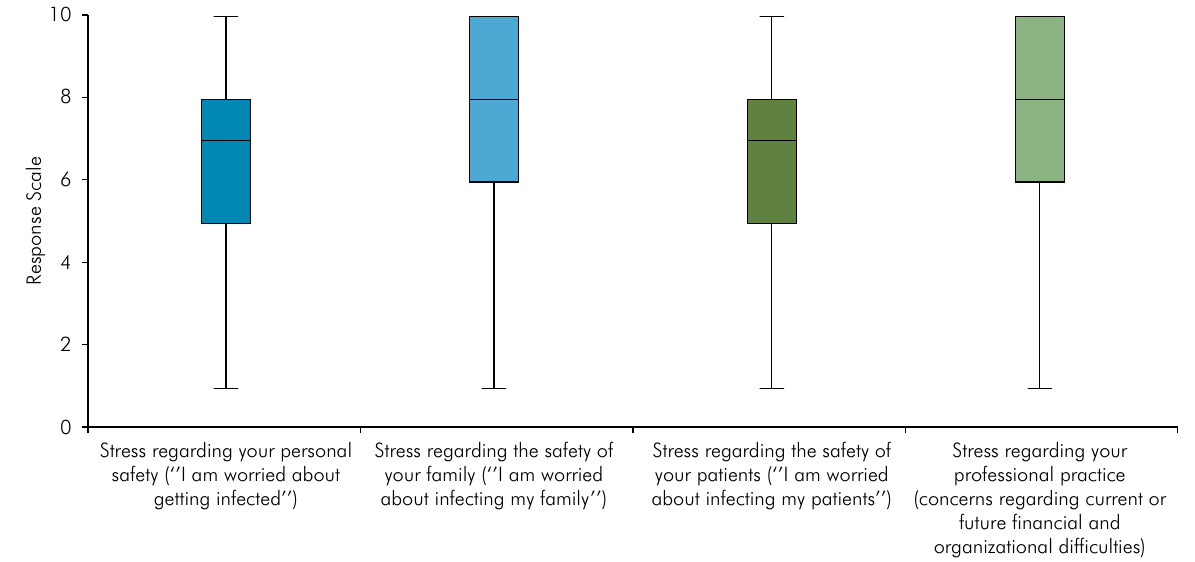
Figure 1. Distribution of perceived stress levels of dentists during the COVID-19 pandemic.